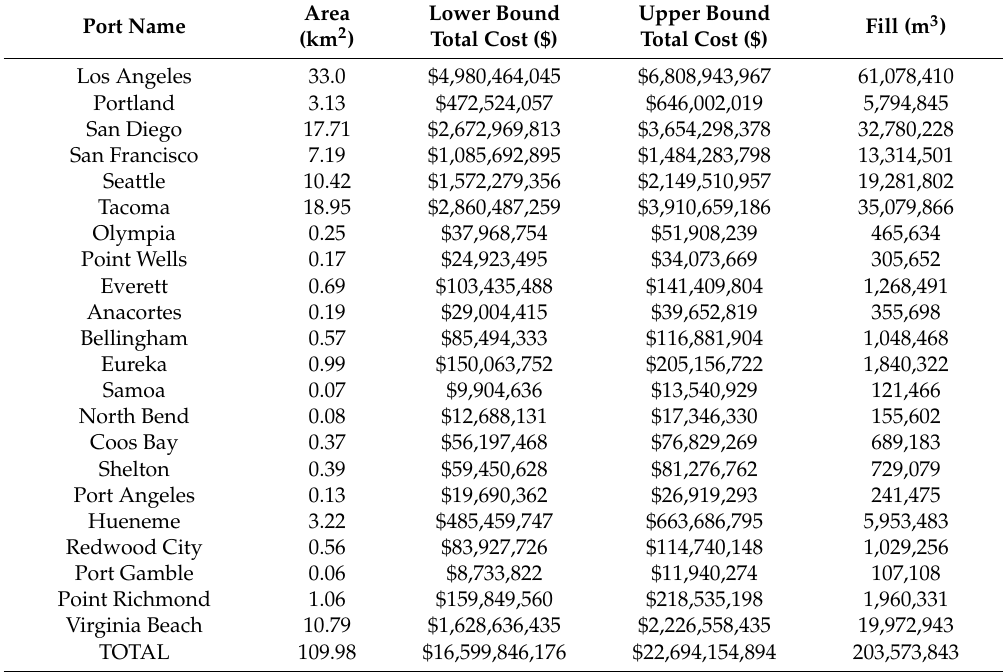
Table A4. Cost and materials required to elevate and retrofit West Coast Seaports in response to two meters of sea level rise.